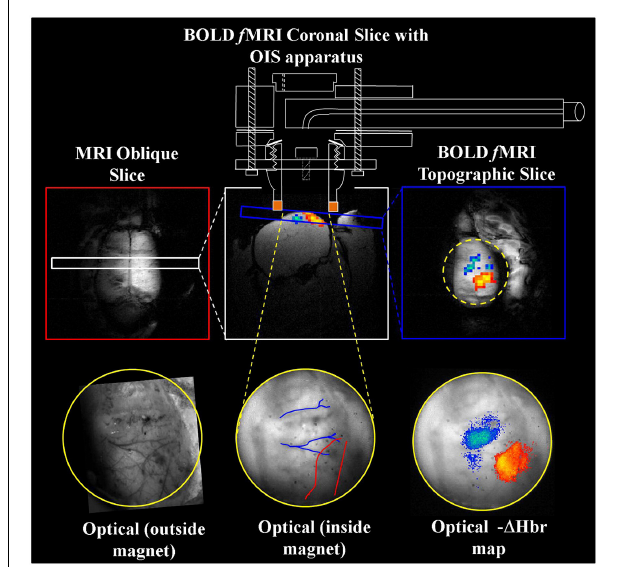
FIGURE 4 | Concurrent fMRI and optical imaging spectroscopy. An oblique slice covering the dorsal surface of the brain (top left) is first used to identify a coronal (top center) or topographic slice (top right) containing the whisker barrel cortex for fMRI data acquisition. Apparatus allowing concurrent optical imaging is illustrated (top), consisting of a specially adapted MRI-compatible endoscope to transmit light to and from the brain surface. Optical imaging data is shown in the bottom panels, including the raw gray scale imaging of the cortical surface visualized through a thin cranial window (left and center), and activation induced changes in deoxyhemoglobin concentration (right) that correspond well to the concurrently acquired fMRI data (top right). Adapted with permission from Kennerley et al.